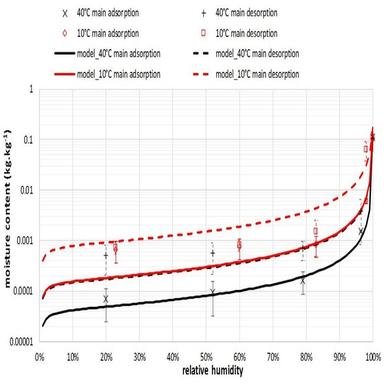
Experimental and modelled main adsorption and desorption curves at 10 C and 40 C.